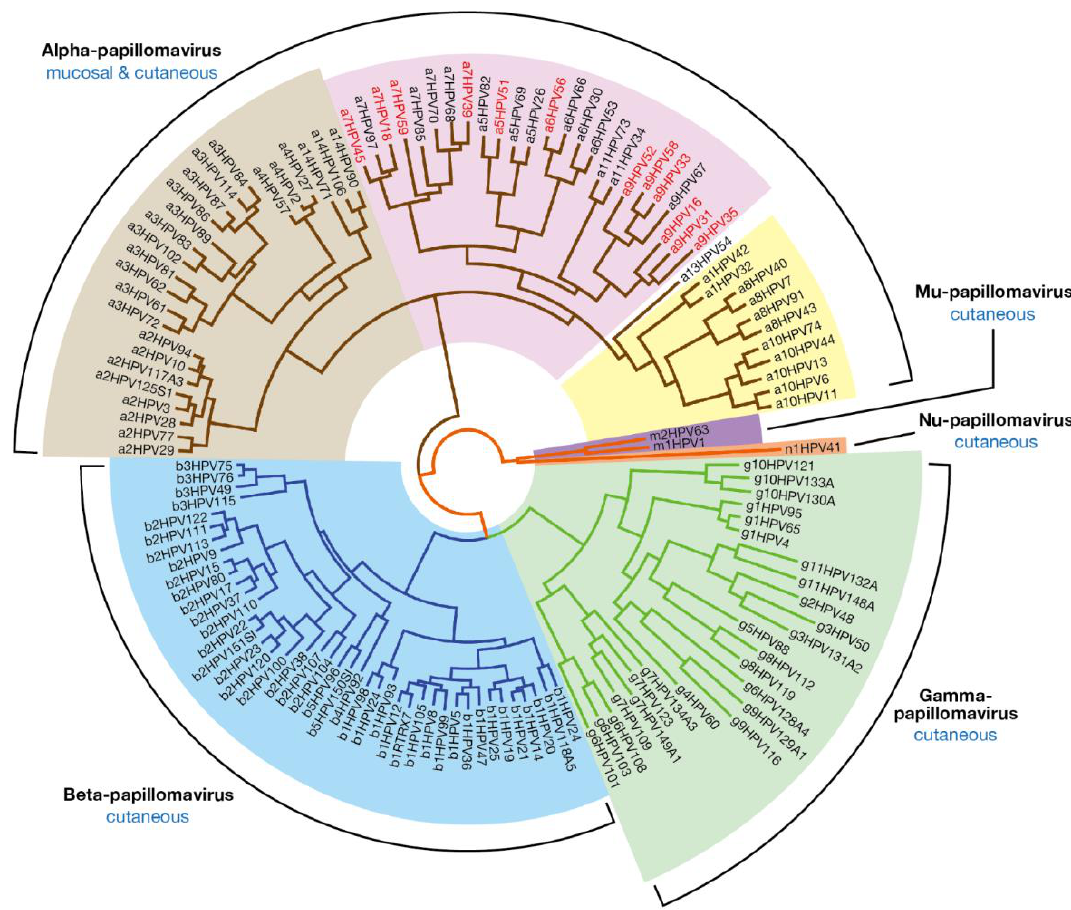
Figure 1. Evolutionary Relationship between Human Papillomaviruses. The human papillomaviruses types found in humans fall into five genera, with the Alpha-, Beta- ( blue ) and Gammapapillomavirus ( green ) representing the largest groups; Human papillomaviruses types from the Alphapapillomavirus genus are often classified as low-risk cutaneous ( light brown ); low-risk mucosal ( yellow ); or high-risk ( pink ) according to their association with